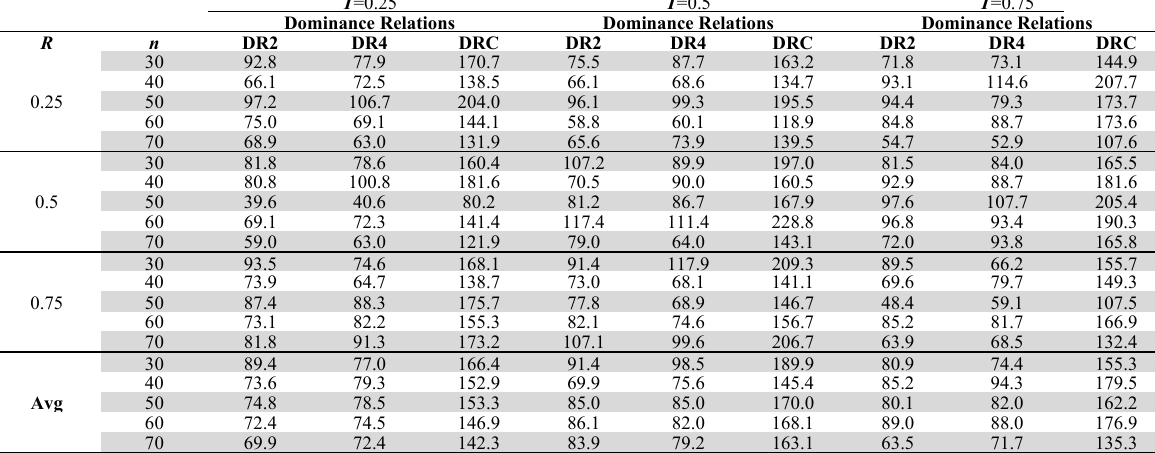
Percentage Improvement of Dominance Relations ( Δ = 20)